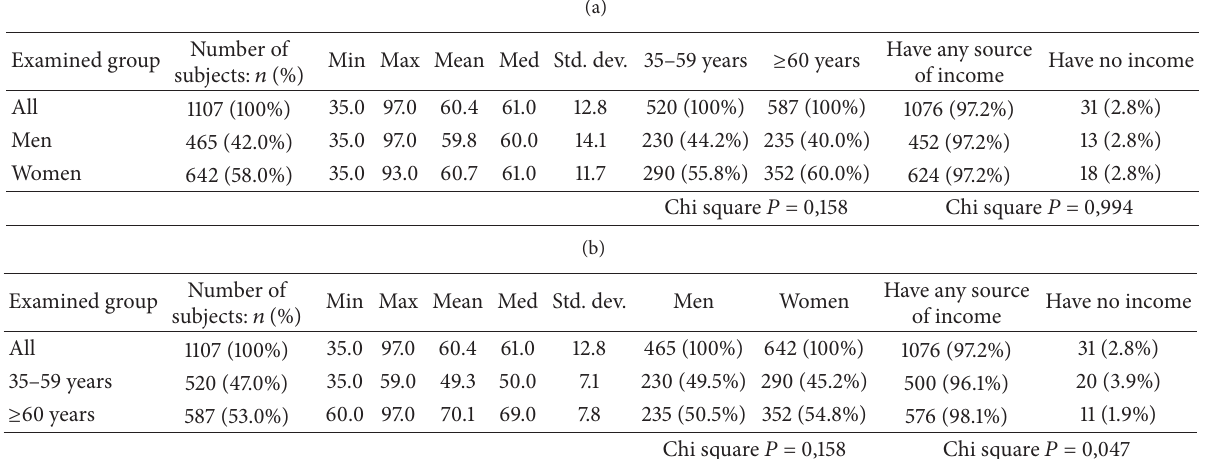
Table 1: Sociodemographic structure of the examined group.